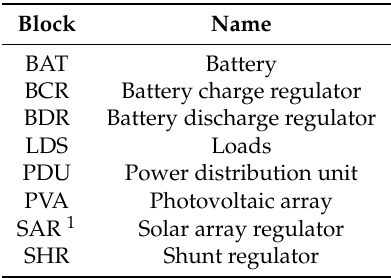
Table 1. Names of the blocks included in Figure 1.